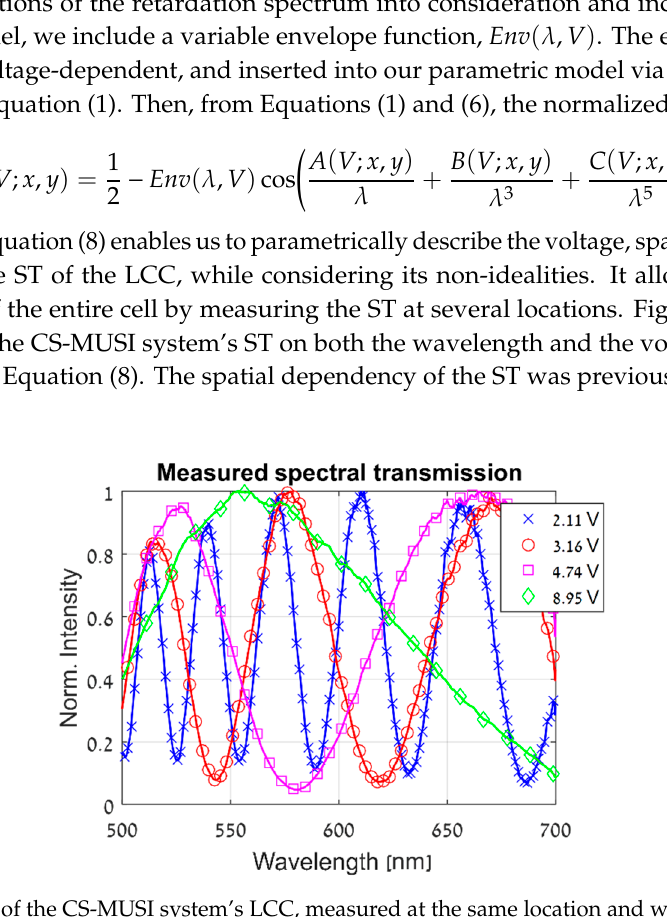
Figure 3. The ST of the CS-MUSI system's LCC, measured at the same location and with four different voltages applied to the LCC.